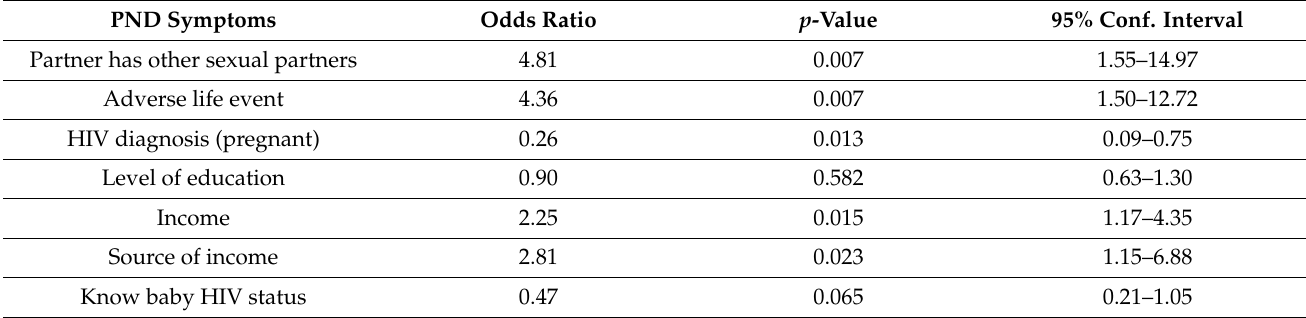
Table 6. Multivariate analysis of social and demographic factors associated with